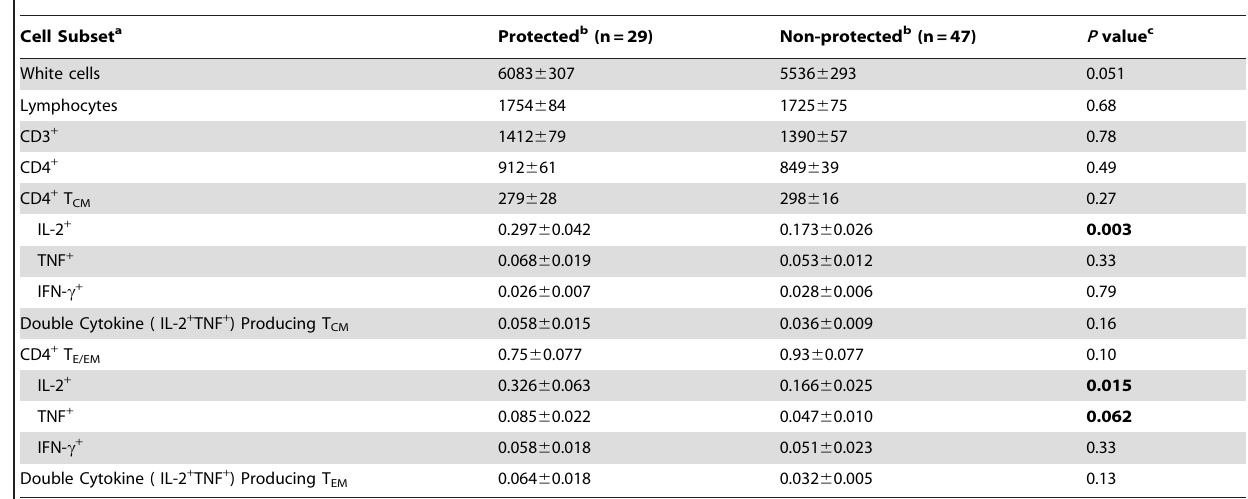
Table 1. Number of cells per subset on the